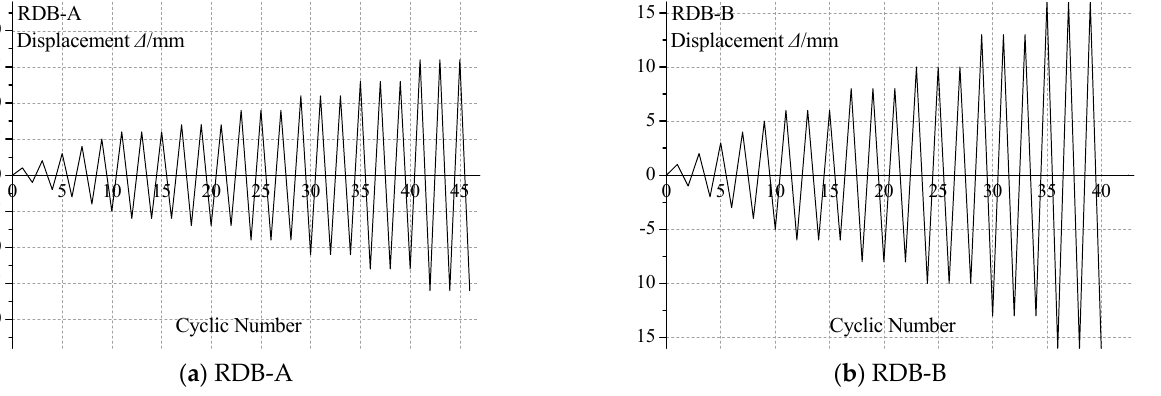
Figure 4. Loading patterns for the test specimens.